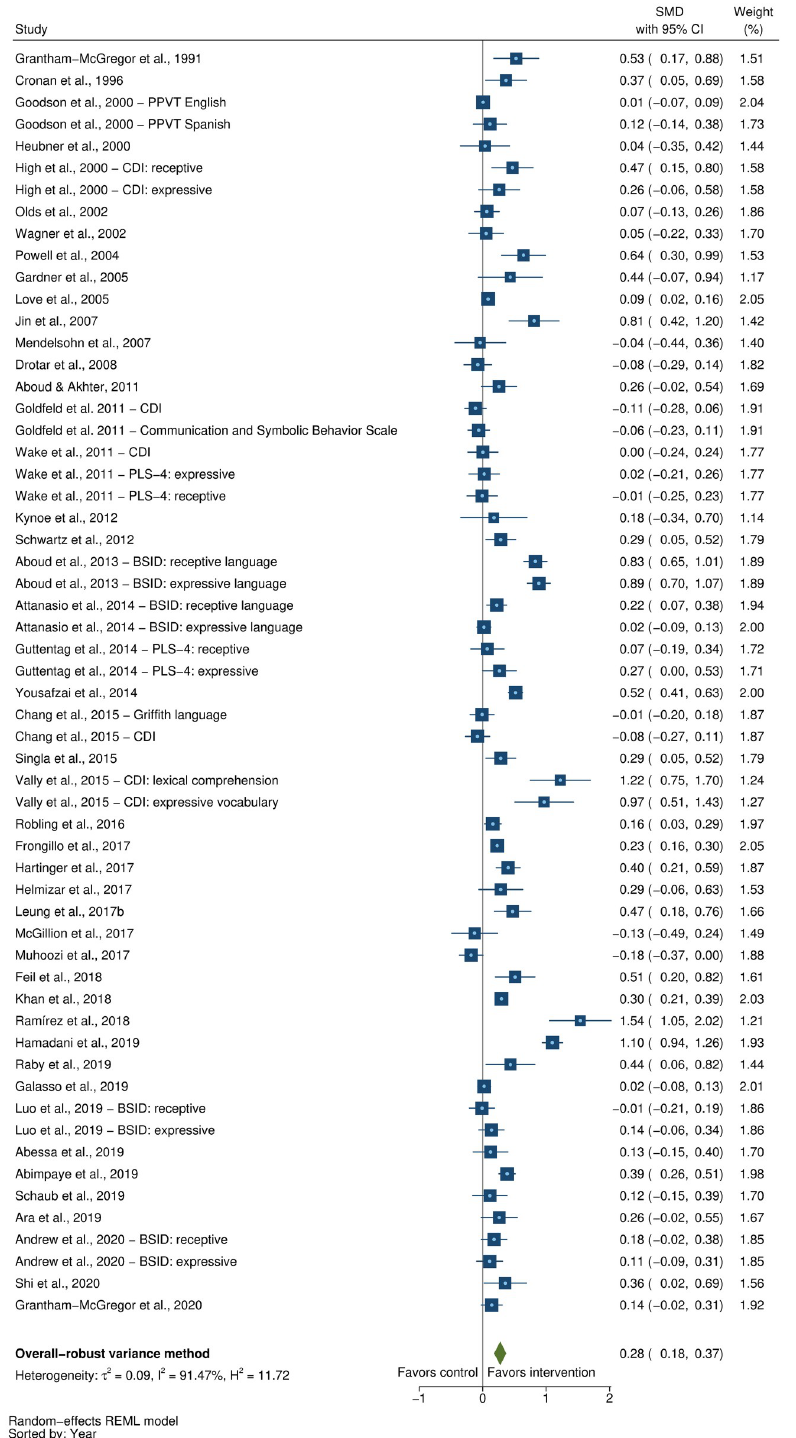
Fig 3. Forest plot for the effect of parenting interventions on language development. Blue squares represent the SMD for each study, with the size of the square being proportional to the study weight. The whiskers extending from each side of the square represent the range of the 95% CI. The green diamond shows the overall pooled effect size using a random-effects model, which is centered at the point estimate and the diamond width representing the 95% CI. SMD, standardized mean